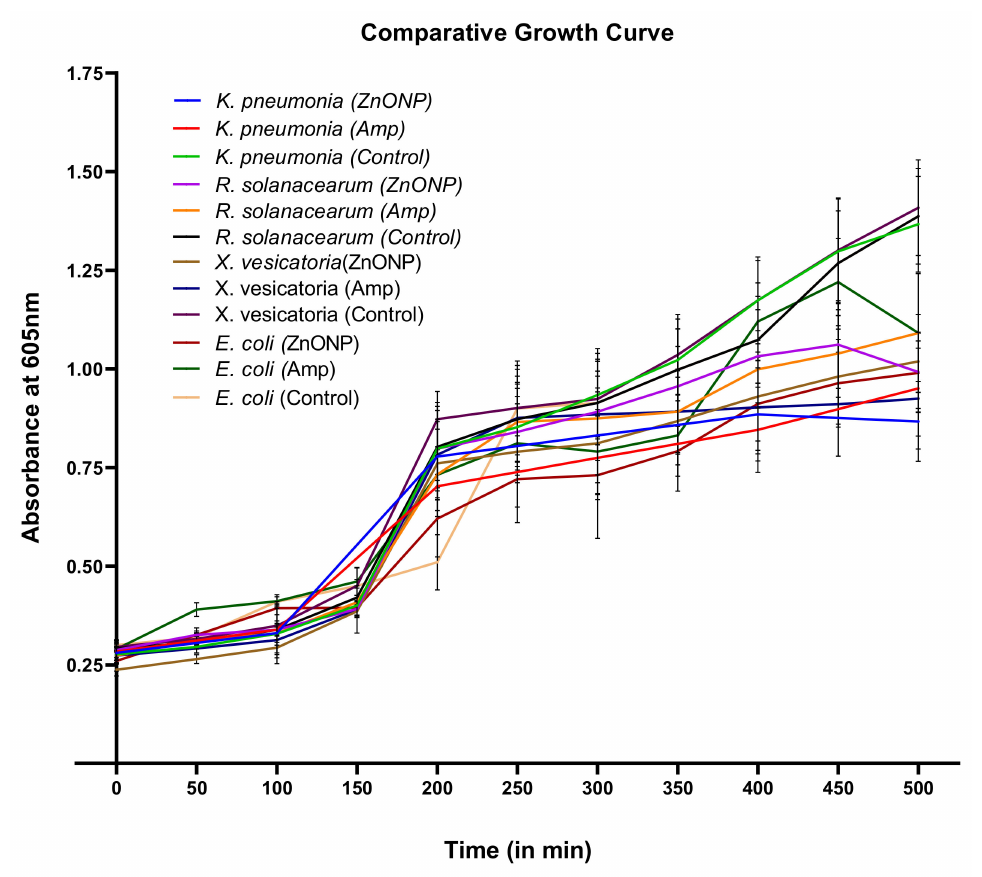
Figure 9. A comparative display of growth curves of test bacteria in the absence and presence of synthesized ZnONPs. Experiments were performed in